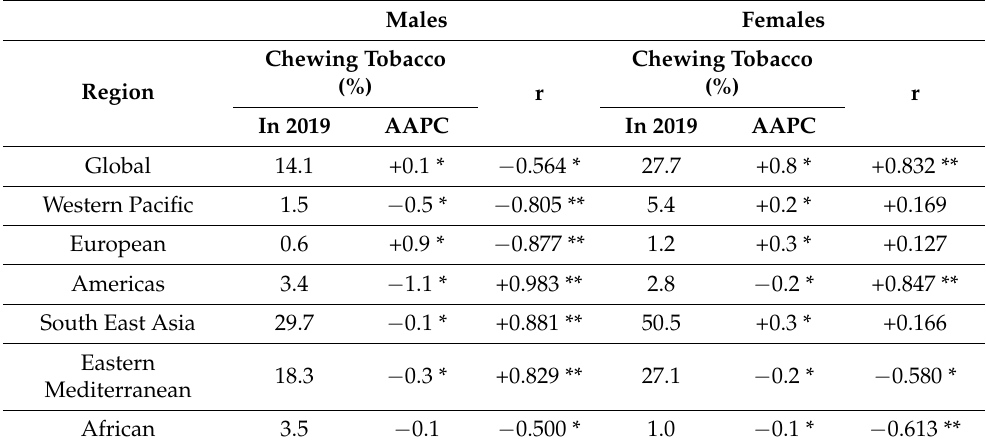
Table 1. Pearson’s correlation coefficients (r) and trends (AAPC) for chewing tobacco with mortality of lip and oral cancer (age-standardized rates per 100,000 persons) by regions and sexes, 1990–2019.